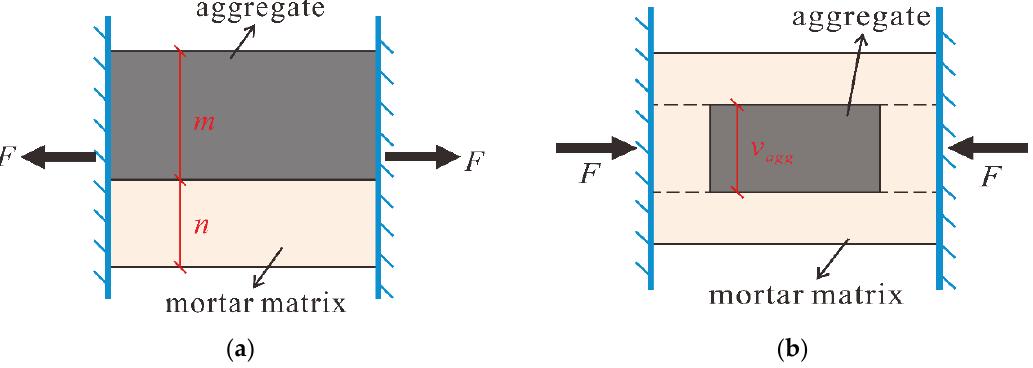
Figure 7. Equivalent model and the modification: ( a ) Existing mechanical model; ( b ) Modification of existing model.